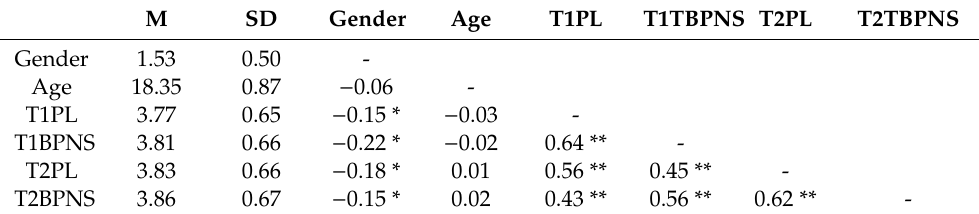
Table 1. Descriptive statistics and correlation matrix of